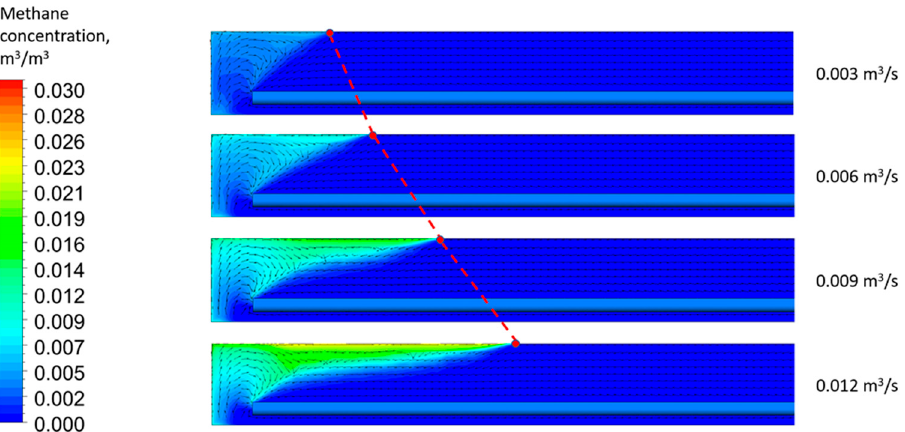
Figure 4. Distributions of methane concentration in a drift at different rates of methane emission; the red line marks the right boundary of the methane cloud flowing against the main airflow.